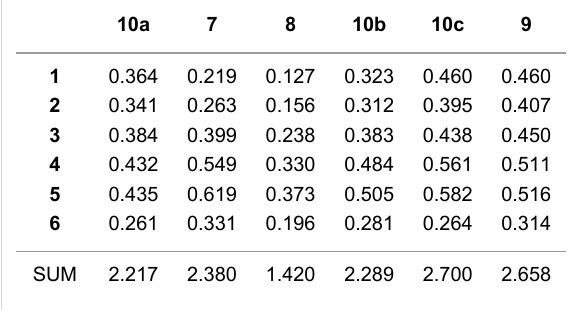
Table 6. In other words, the combination of the hydrophobic alkyl chains and the CD cavity seems to provide a coating with a very high capacity for uptake of VOCs. Table 6: Maximum uptake (µmol VOC/µmol cavity) of the various VOCs by each amphiphilic CD derivative. The amphiphilic CD deriva- tives are ordered by ascending